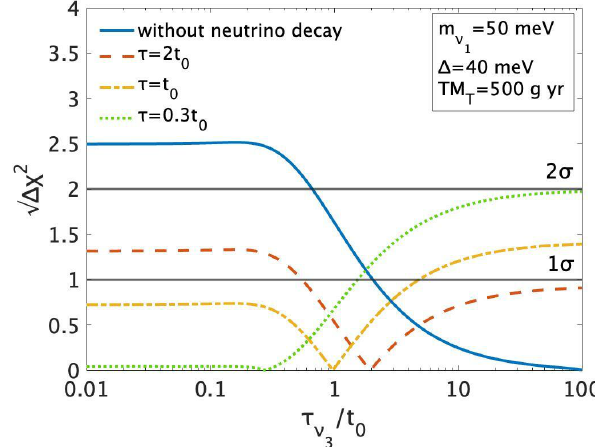
q p ∆ ∆ χ 2 , as a function of τ for ν in the NO case with χ 2 , ν 3 3 → ν 1 φ 1 − D = 500 g yr. The fiducial value of ( ˆ τ T 0) (red dashed), ( t 0) (yellow dot-dashed), and (0 . 3 t 0 , 0 , for ν ¯ ν in the NO case with ν 3 3 → ν 1 ν 4 4 = 500 g yr are almost the same with those T